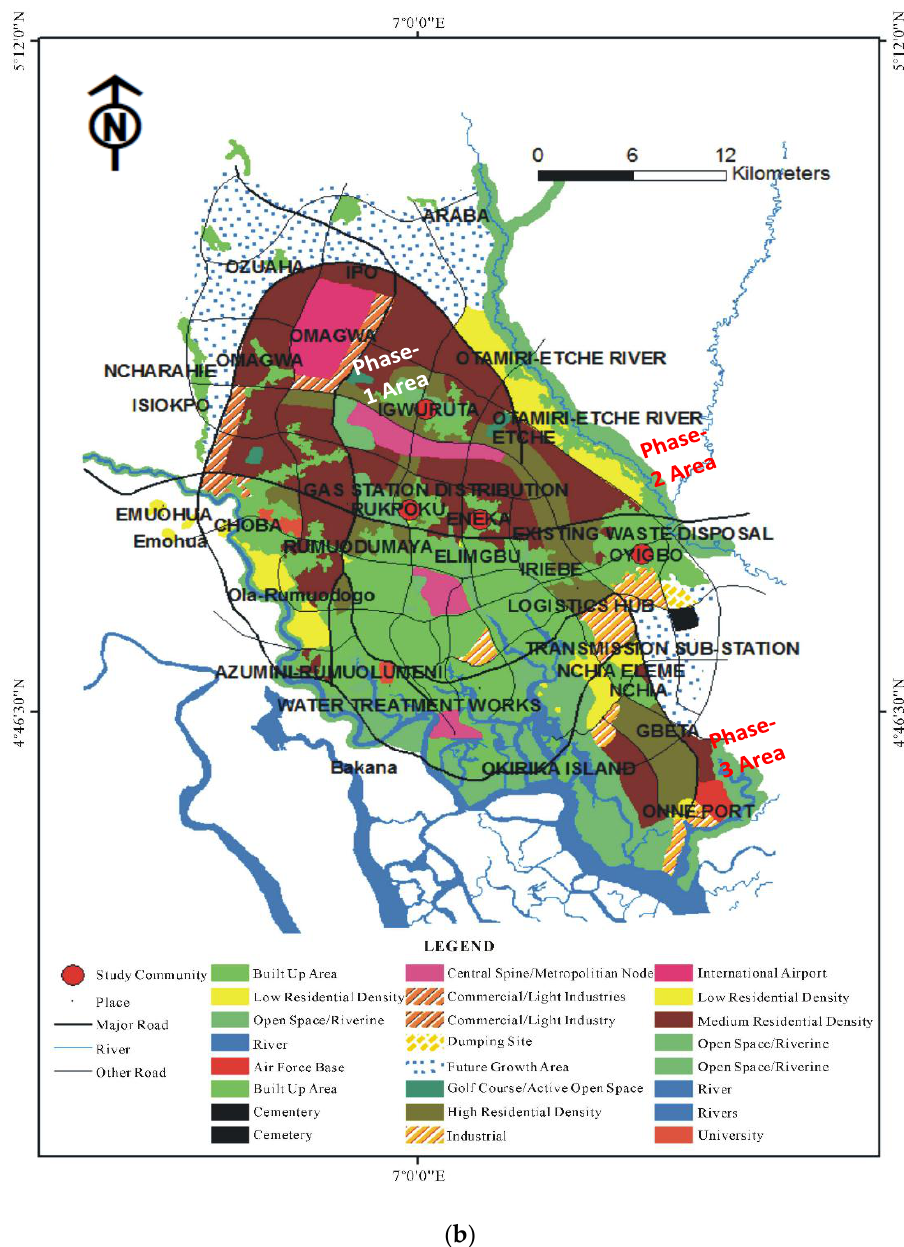
Figure 1. ( a ) Map showing the Greater Port-Harcourt (GPH) Phase 1 location alternatives in the studied watershed. ( b ) Land-use/land cover layout of the GPH Master plan showing position of Phases 1, 2 and 3 areas within the new city (Source: Greater Port-Harcourt Development Authority (GPHDA), 2008).